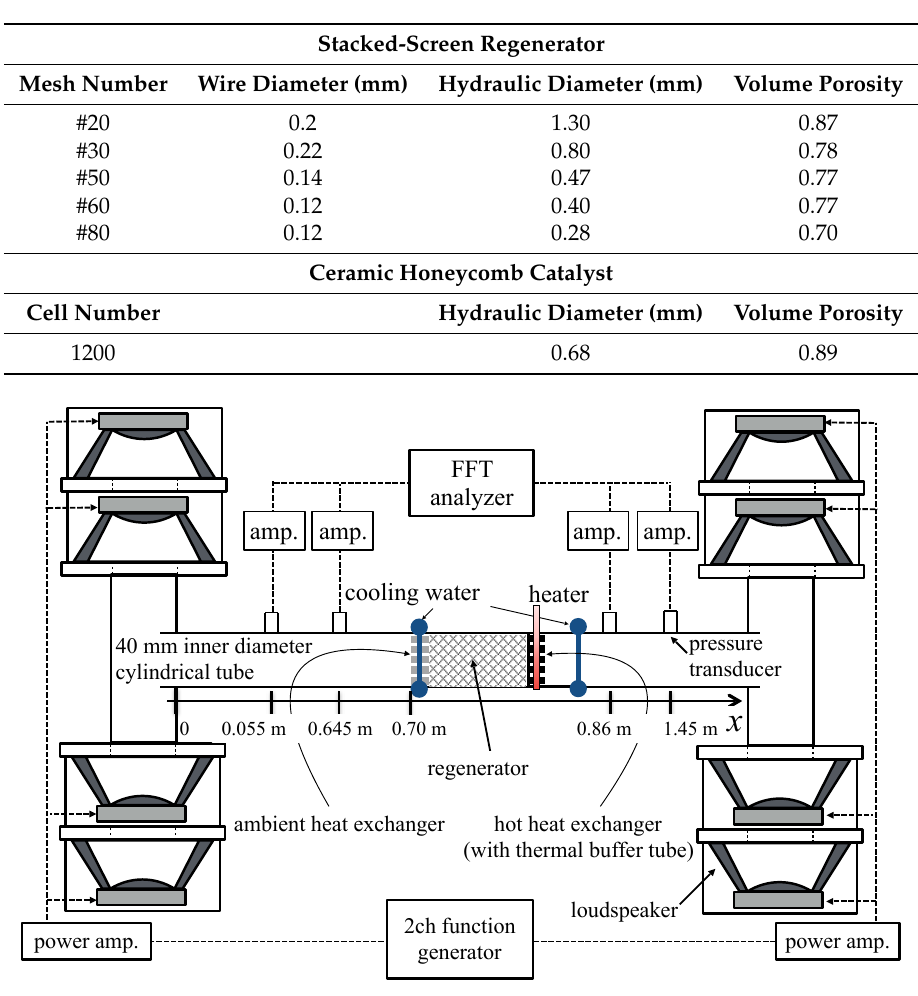
Figure 1. Schematic diagram of the experimental